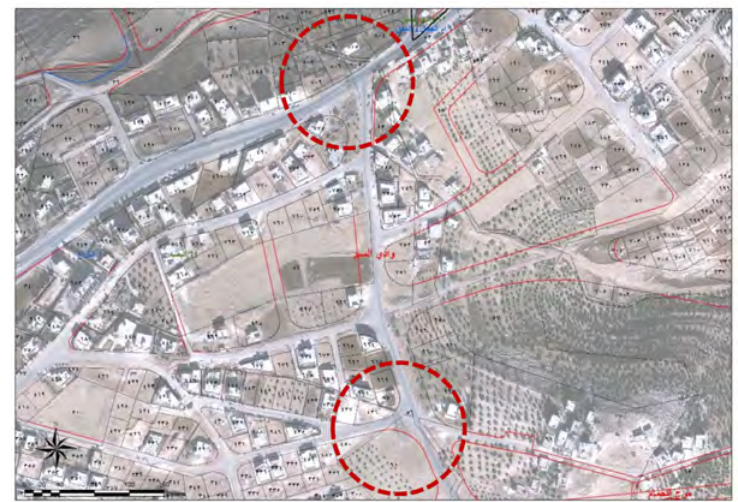
Figure 27. Near high voltage site aerial view map. Source: GAM- GIS for the author (2016).